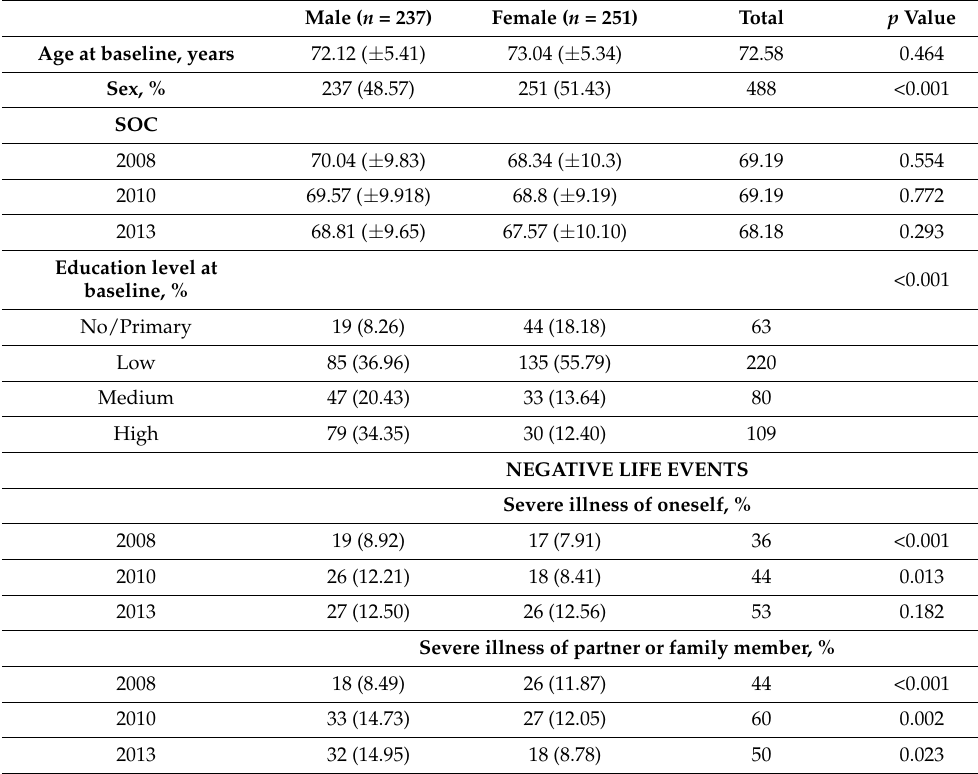
Table 1. Characteristics of the study population according to